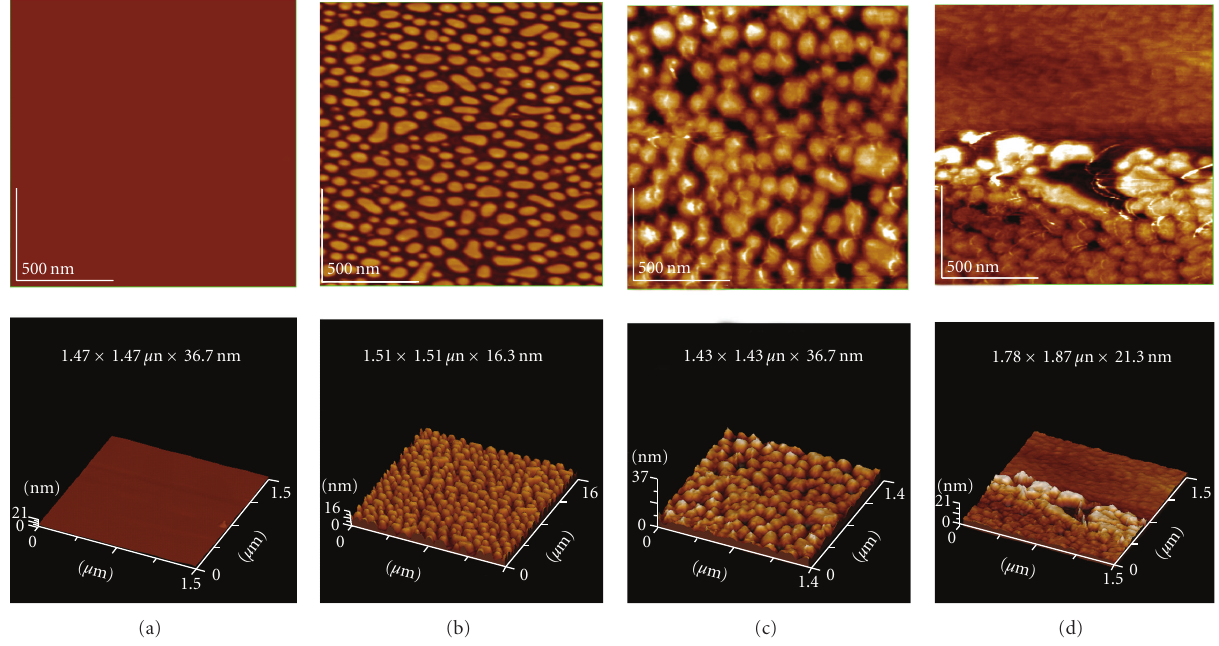
Figure 4: AFM images of A β P(1–40) on monolayer membranes. Lipid monolayer membranes composed by DPPC (a) or ganglioside GM1-DPPC (dipalmitoil phosphatidyl choline) (b) ∼ (d) were prepared by bath sonication and reconstitution on mica plates. The ratio of GM1:DPPC was 8: 2. AFM images were obtained after the exposure to freshly prepared A β P(1–40) (c) or aged A β P(1–40) (d). Scale area: 1.5 × 1.5 μ m.